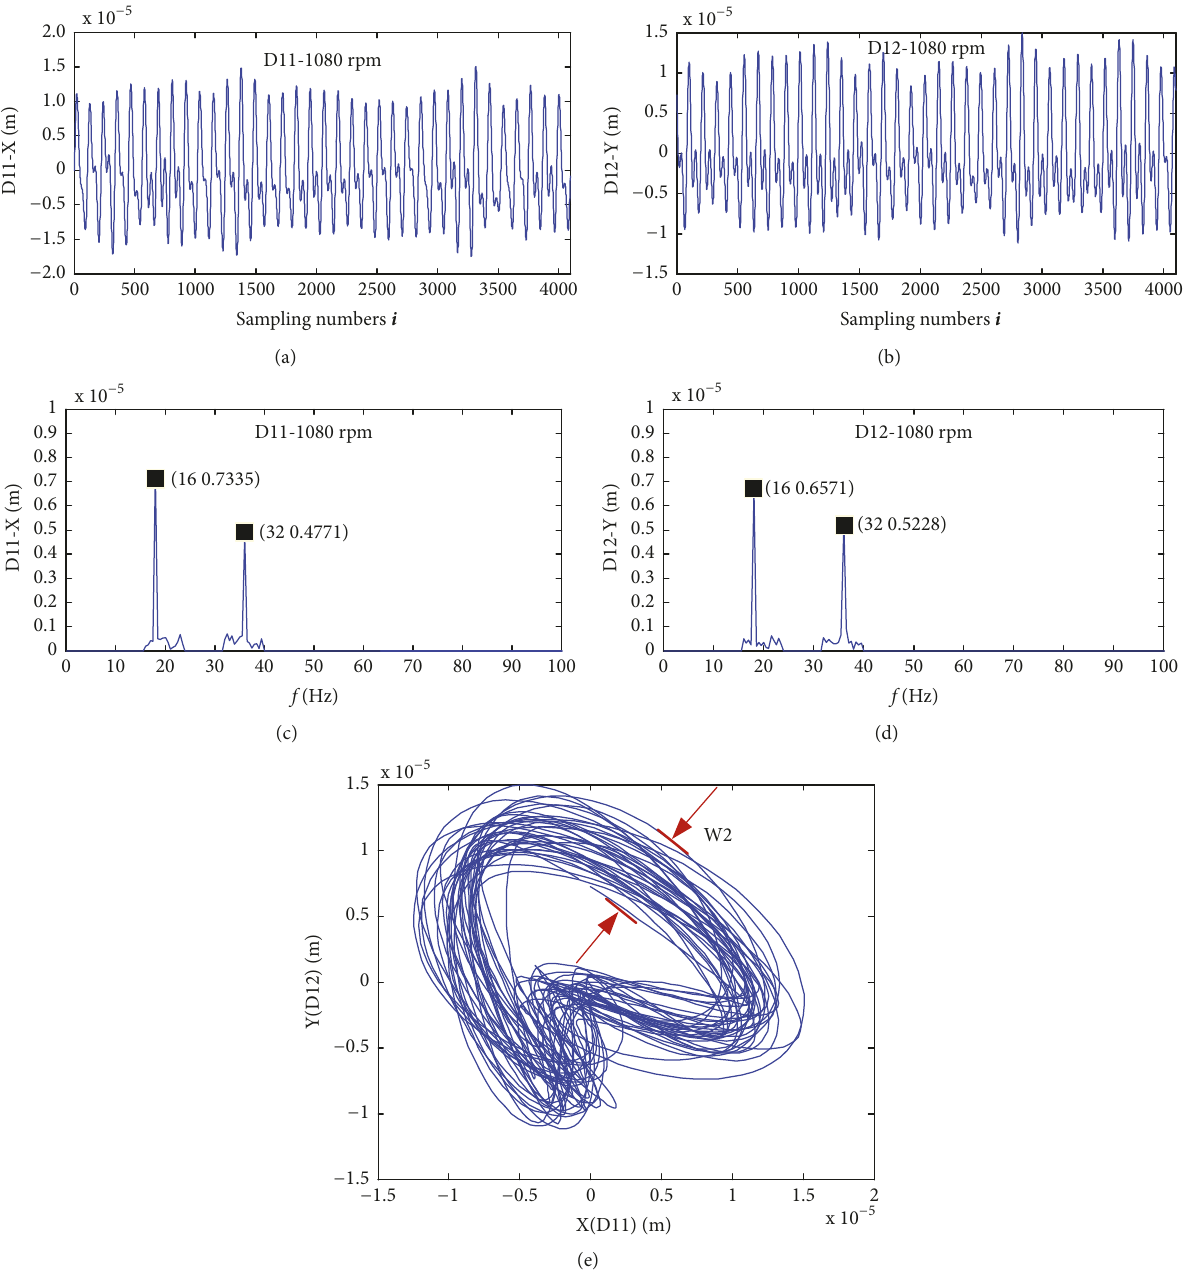
by amplitude 𝐴 𝑖 of signal frequency component. The larger magnitude of amplitude is, the greater eigenvalues are, and the higher arrangement will